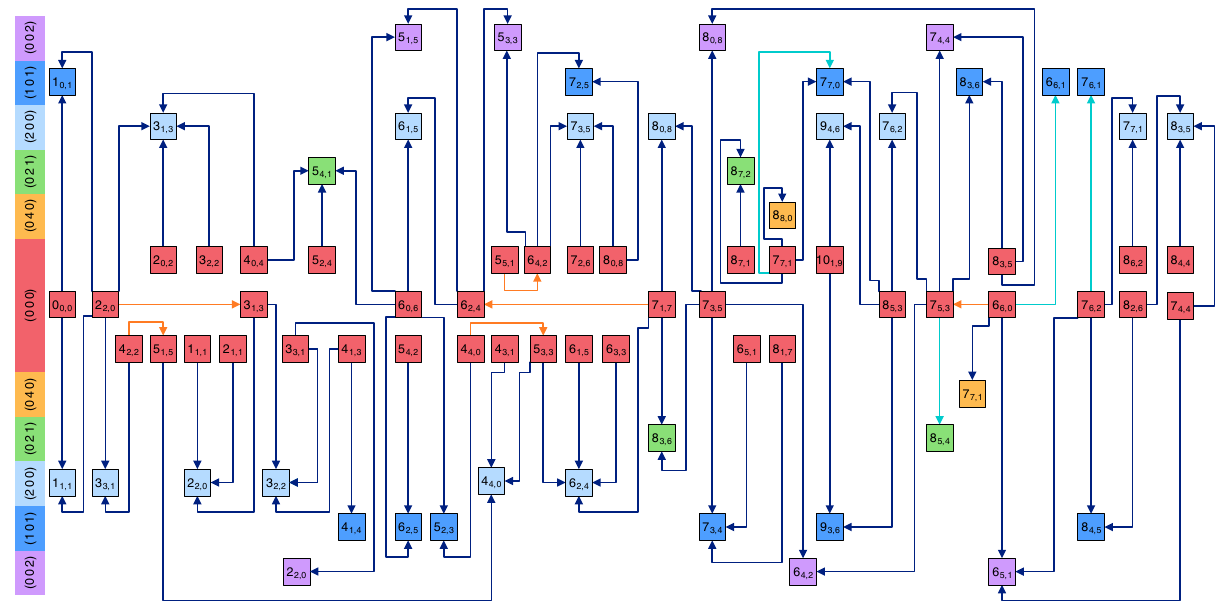
Fig. 3 Pictorial representation of all the precision measurements for para -H 2 16 O. The para energy levels (characterized with even v 3 + K a + K c values and denoted with squares) are placed palindromically in increasing (upper half) and decreasing (lower half) energetic order of their vibrational parents and distinguished with different colors for improved transparency. The J K rotational labels 70 are indicated individually for each rovibrational state, while the a ; K c ( v 1 v 2 v 3 ) vibrational assignments 69 are marked in the left-side color legend. Transitions with blue arrows are results of the present NICE-OHMS experiments, while those with orange and cyan colors are taken from refs. 37,42 , respectively. Source Data are provided as a Source Data fi